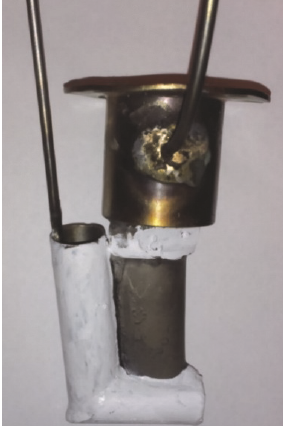
Figure 7: The blade model prepared for test.